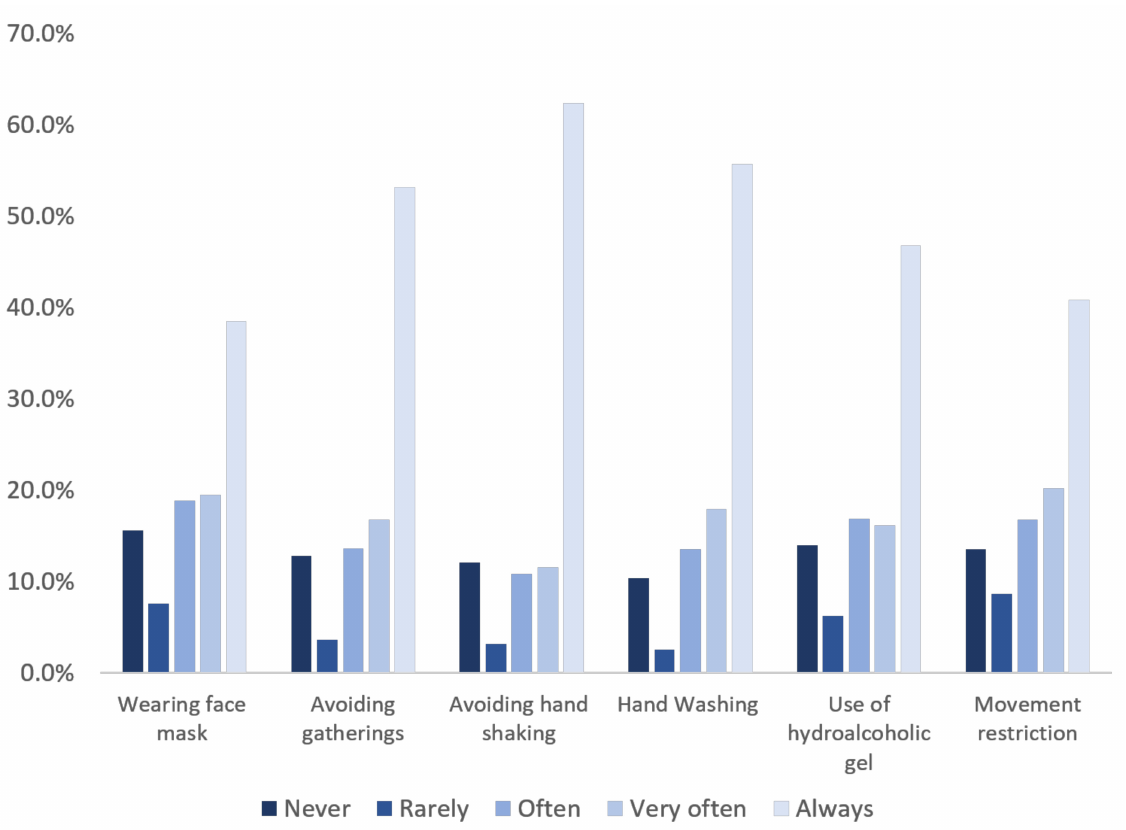
Figure 3. Adoption of issued preventive measures for the management of the COVID-19 by the respondents. Study conducted from 26 April to 16 May 2020 in C ô te